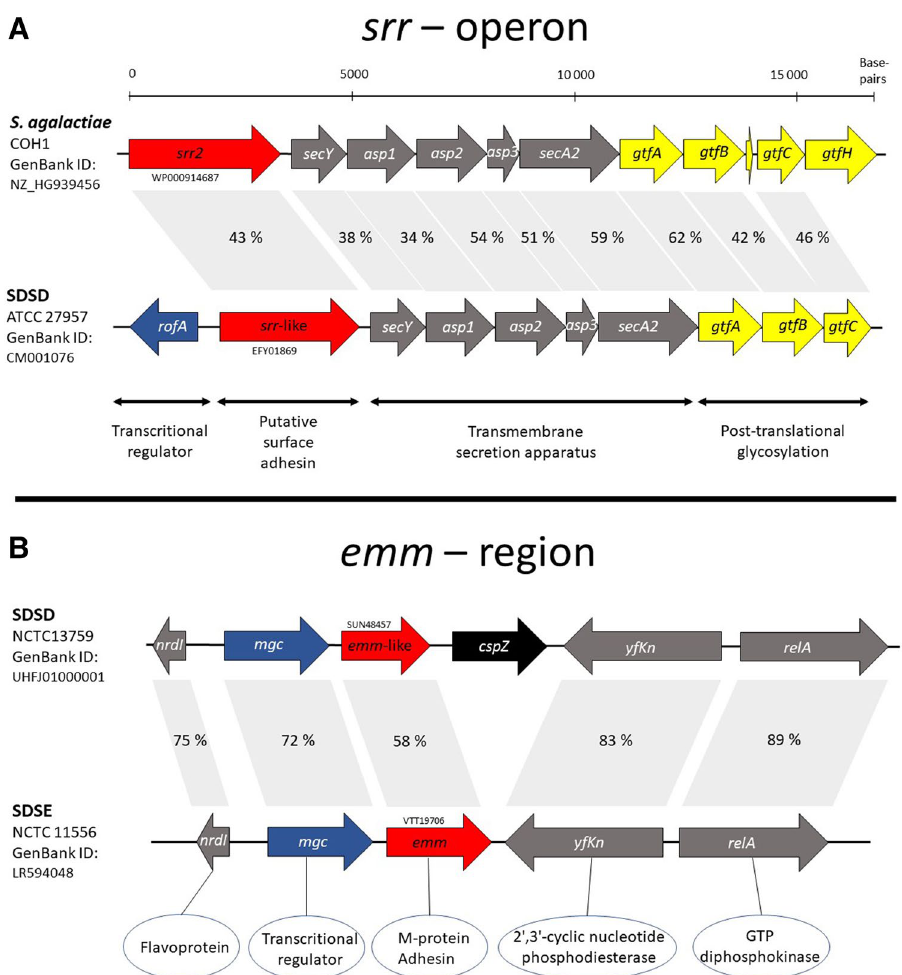
Figure 1. Genetic organization of the Srr-locus and emm —region in Streptococcus dysgalactiae. Panel A depicts a comparison of the novel srr -like locus detected in SDSD to the srr -operon of S. agalactiae . Two distinct srr variants have been described in S. agalactiae , denoted srr1 and srr2 . The srr -like gene and rof A transcriptional regulator in SDSD is more similar to srr1 of S. agalactiae . However, the overall genetic organization of the SDSD srr -like operon resembles the srr2 -locus, and is thus presented in the figure. The functional descriptions are inferred from the characterization of the srr -locus in S. agalactiae (ref Mistou (ref 10)). Panel B shows an alignment of the emm —region in SDSD and in human associated SDSE isolates. SDSD genomes harbour an additional gene, cspZ , predicted to encode a cell wall surface